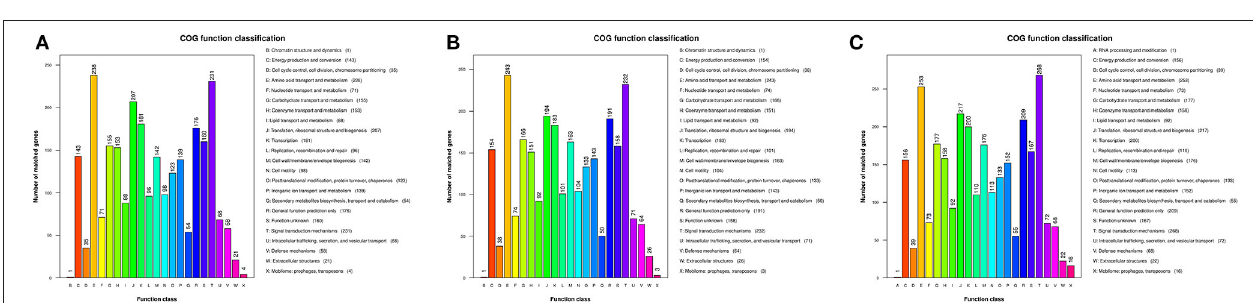
FIGURE 4 | Functional classification of V . cholerae core genome COG functions. (A) COG functional classification of the core genomes of reference environmental V . cholerae strains; (B) COG functional classification of the core genomes of migratory bird V . cholerae strains; (C) COG functional classification of the core genomes of V . cholerae pandemic strains retrieved from the GenBank